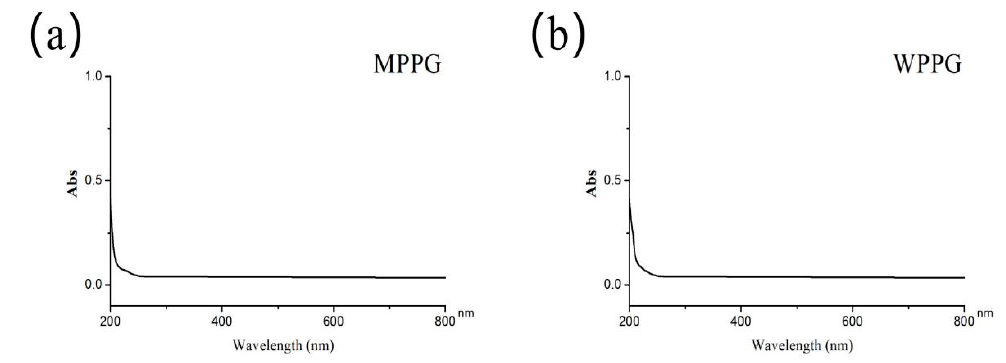
Figure 4. UV spectrum of MPPG ( a ) and WPPG ( b ).